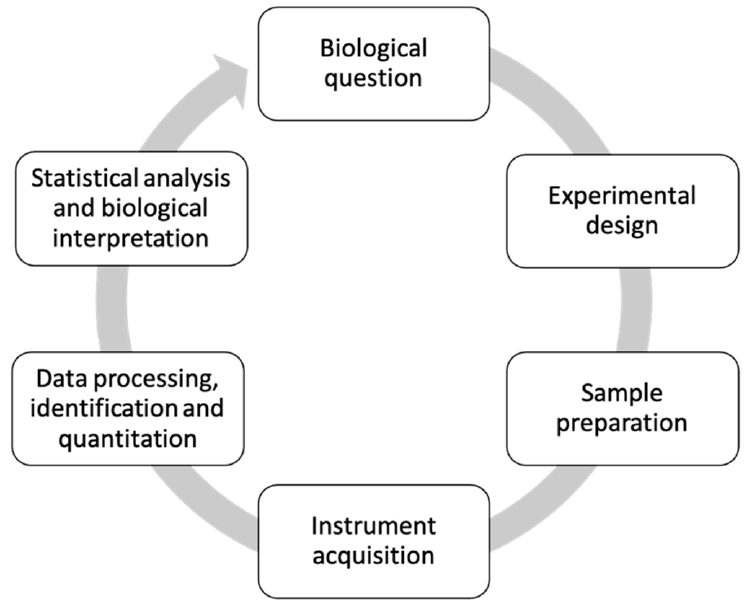
Figure 1. Metabolomics workflow.